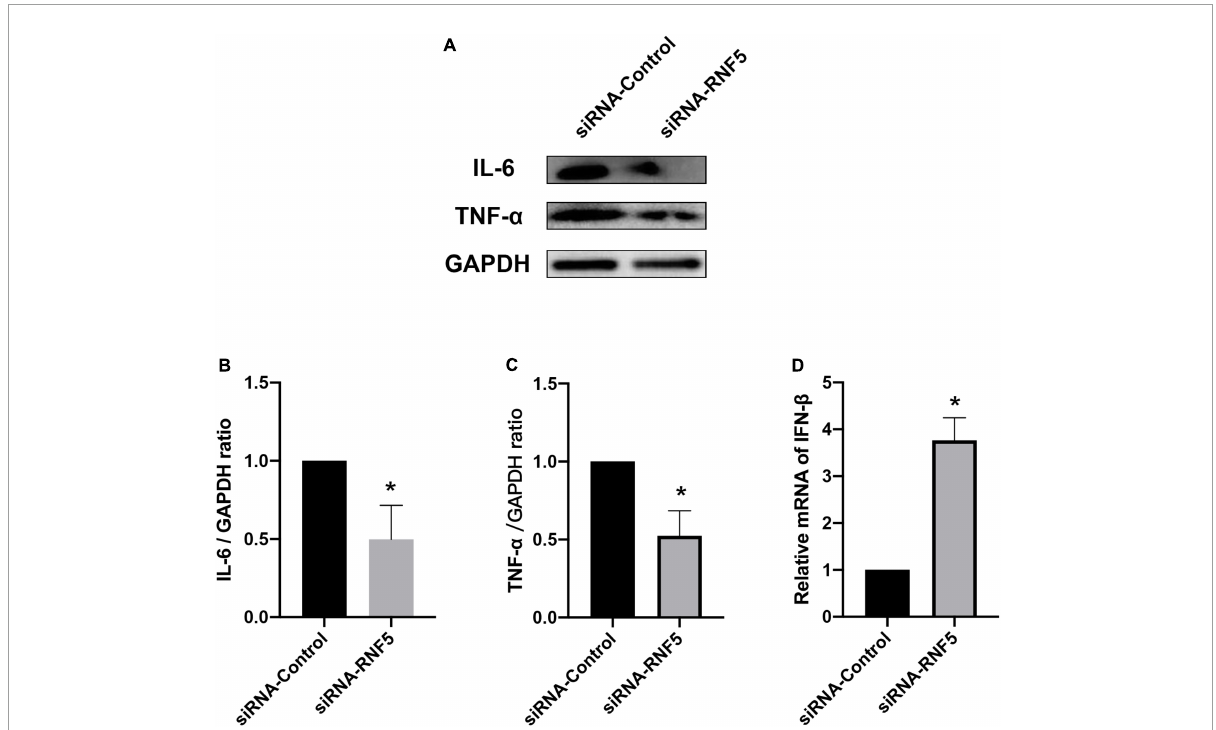
FIGURE6 Effects of RNF5 silencing on cytokine secretion in mouse HSK. (A) Mice were infected with HSV-1 after RNF5 silencing, and the mouse corneas (3 mice/group) were harvested on the 3rd day after the infection. The expression levels of interleukin (IL)-6 and tumor necrosis factor (TNF)- α were detected by Western blotting. (B) Statistical graph of relative gray values of corneal IL-6 levels, with GAPDH as the internal reference. (C) Statistical graph of relative gray values of corneal TNF- α levels, with GAPDH as the internal reference. (D) Mice were infected with HSV-1 after RNF5 silencing, and the mouse corneas (3 mice/group) were harvested on the 3rd day after the infection. The mRNA expression of RNF5 was detected using quantitative PCR, with GAPDH as the internal reference. Data are shown as mean ± SD of three independent experiments. * P <